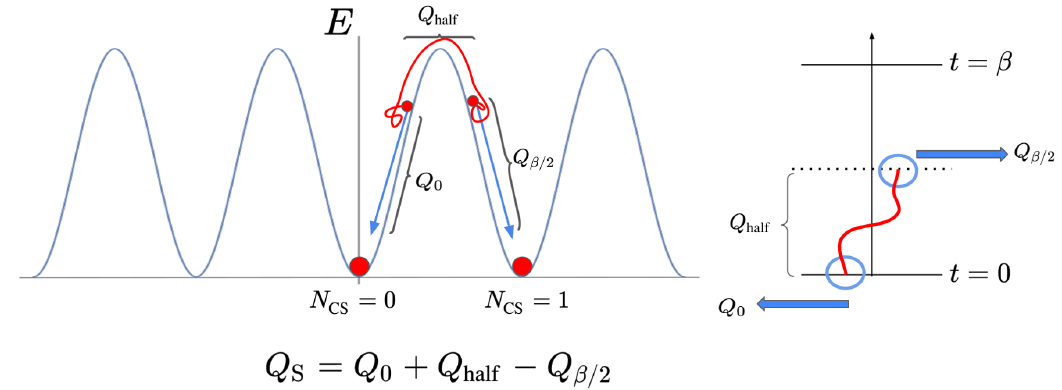
Figure 5 . How we define and identify sphalerons in QCD. The topological density is integrated between t = 0 and t = β/ 2 , and supplemented by its integration as these two boundaries are gradient-flowed to the vacuum. When the configuration crosses a separatrix, the result is ± 1